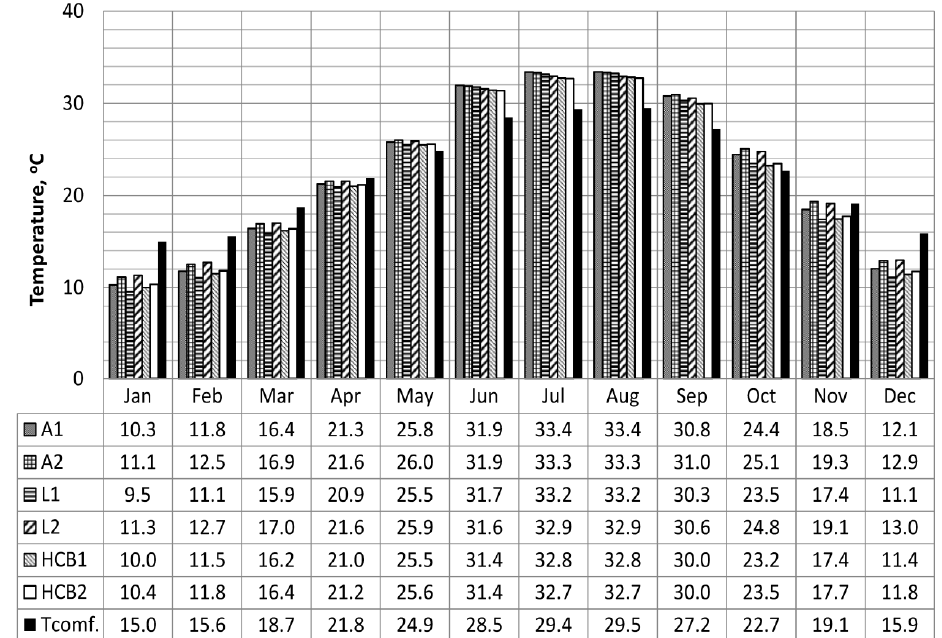
Figure 7. Monthly average indoor temperature for six different wall constructions compared with the comfort